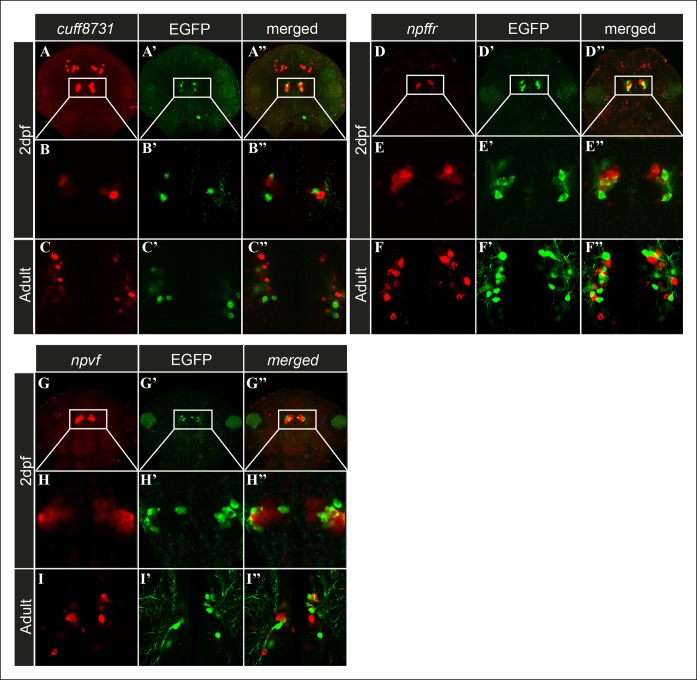
Candidate genes are expressed in cell populations located adjacent to Hcrt neurons.(A–I'') Fluorescent ISH and immunofluorescence experiments in 2 dpf larvae and adult hcrt:EGFP zebrafish showing three candidate genes that are expressed adjacently to Hcrt neurons within the hypothalamus. (A–A'', D–D'', G–G'') Dorsal view of the heads showing the whole expression pattern of the genes in 40 µM z-stack. (B–B'', E–E'', H–H) Dorsal view of single 0.5 µM plane in 2 dpf larvae. (C–C'', F–F'', I–I'') Dorsal view of single 0.5 µM plane in adult brain section.